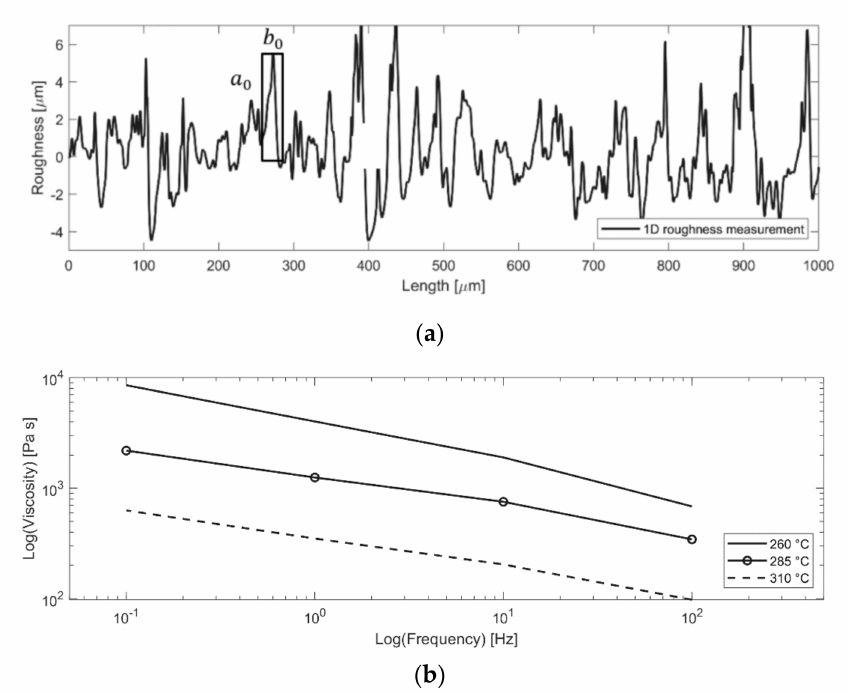
Figure 12. ( a ) One − dimensional surface roughness measurement on the ‘connecting’ surface of the pin; ( b ) Frequency- and temperature-dependent viscosity measurement of the pins material PA66